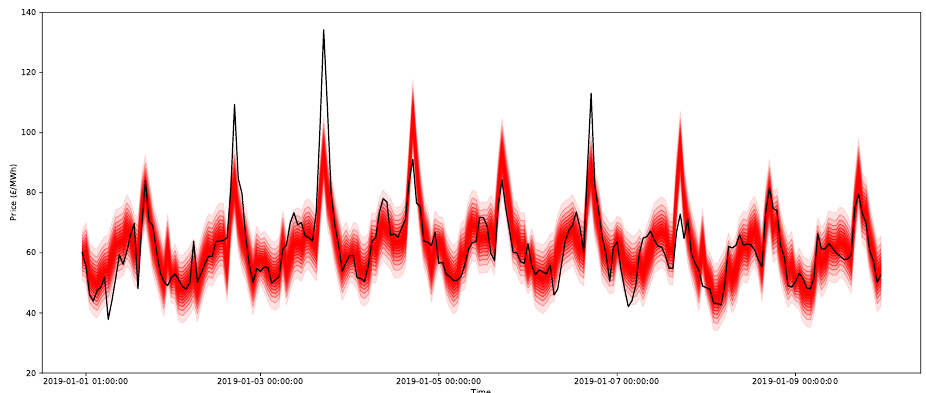
Figure 16. Sample of the ARIMAX model’s forecast for the first nine days of the test set. The different confidence bounds are given different shades, with the darkest representing the prediction interval for the middle ten percent. The actual prices are given by the black line.